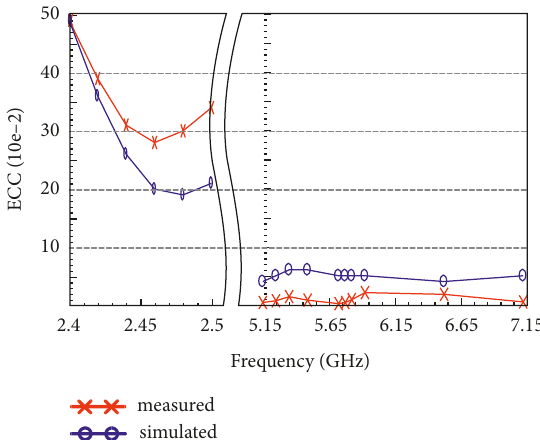
Figure 6: Calculated ECC using the radiation patterns of Ant1 and Ant2. Table 1: Comparison of the proposed design and other cited works [9–25]. λ is the free-space wavelength at the lowest frequency in the designed frequency band. Isolation is the largest value (worst case) over all the obtained bands.